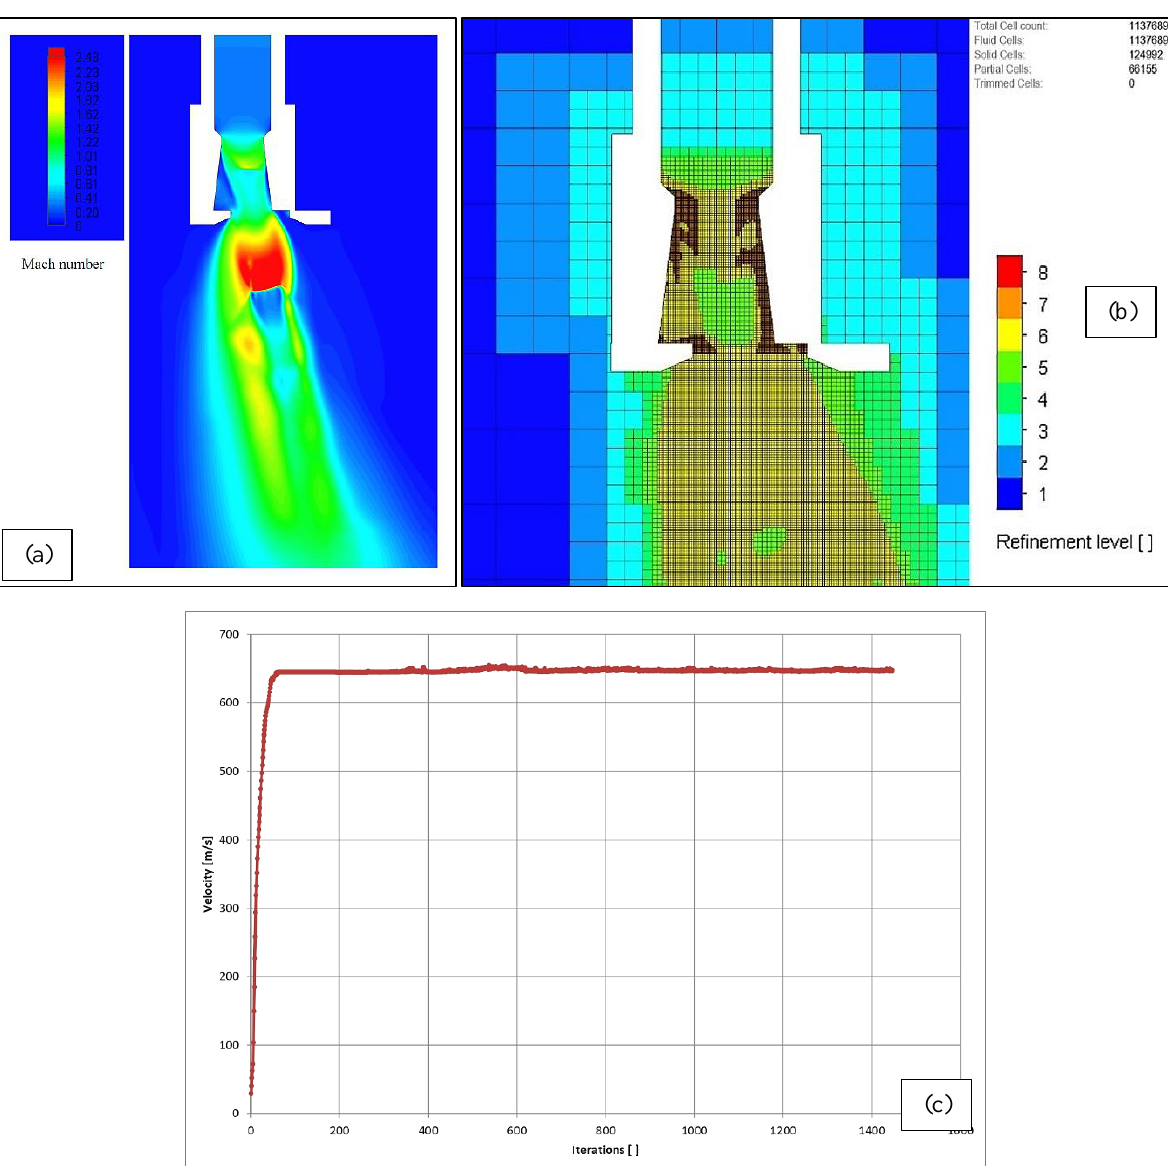
Figure 26. Gas outflow pattern when the diaphragm is radially displaced relative to the nozzle: (a) Calculation data; (b) A fragment of the adapted computational grid; (с) A fragment of the report on the calculation data convergence. Based on the calculations performed, it can be confirmed that using the known design of the expanding nozzle with a flat diaphragm, the largest jet deflection angle at the nozzle outlet can vary within a narrow range from +20 o to -20 o . The nozzle design was further modified when the cone angle γ2 was increased to 60 o (according to the structural model in Figure 23). A series of calculations were performed to assess the technical capabilities of the modified nozzle equipped with a diaphragm. Calculations were performed for conditions using gaseous and liquid model media, and similar results were obtained in two different media. Different calculation results are presented graphically in Figures 27-29.